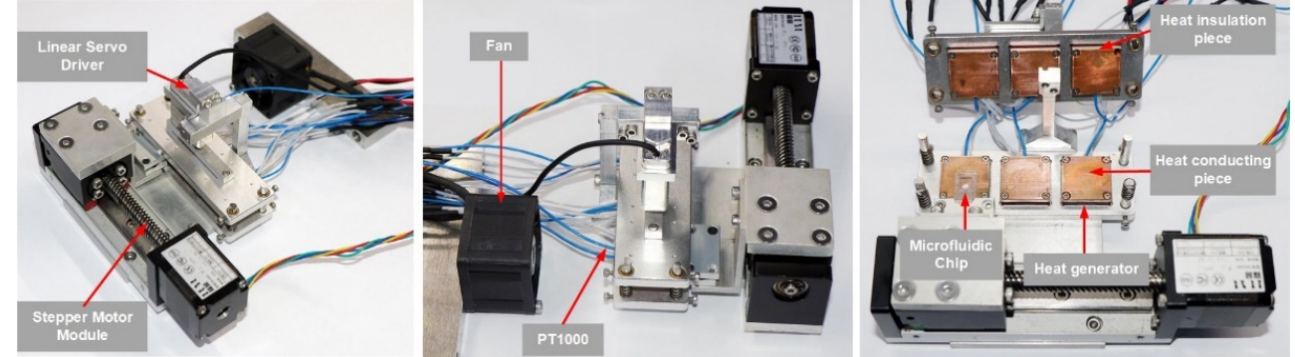
Figure 5. Thermocycler prototype.